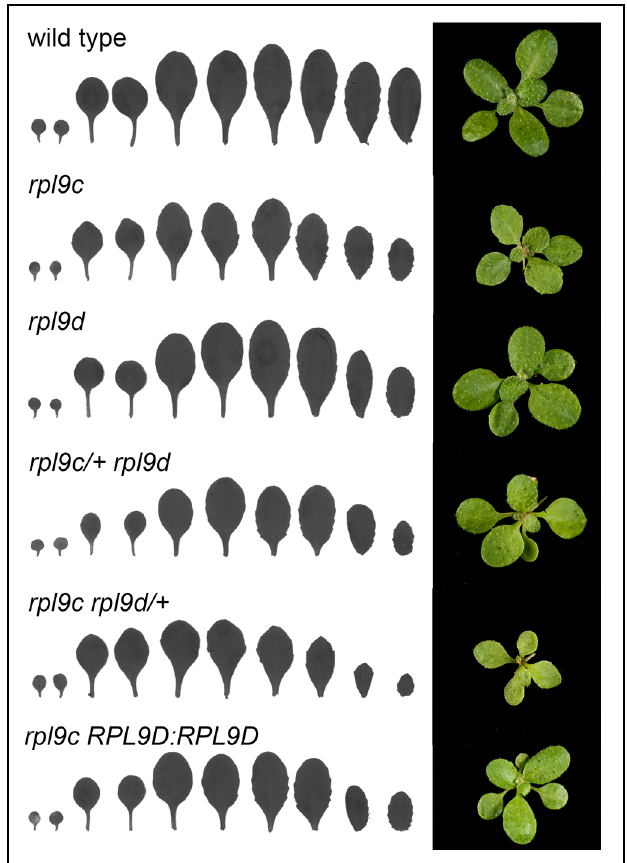
FIGURE 1 | RPL9C and RPL9D have redundant functions in leaf development. Silhouettes (left) and rosettes (right) of wild type, rpl9c , rpl9d, rpl9c/ + rpl9d, rpl9c rpl9d/ + , and rpl9c homozygous for the transgene RPL9D:RPL9D